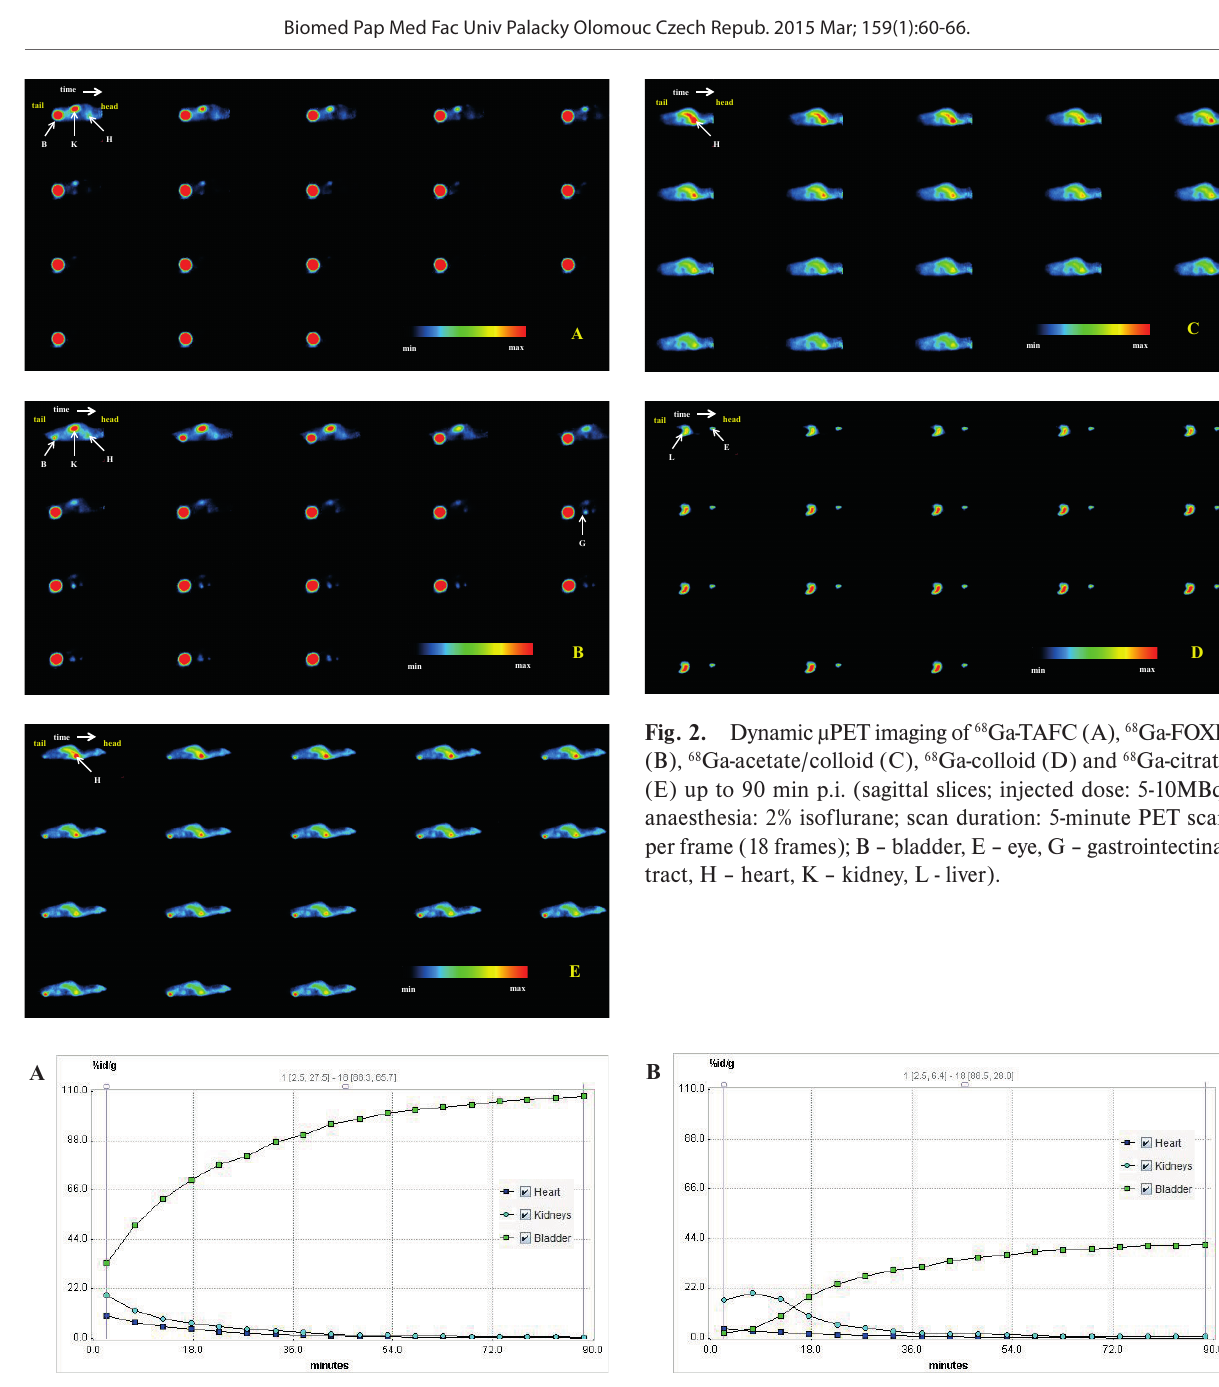
Fig. 3. Time activity curves of selected regions of interest (heart, kidneys, bladder) of 68 Ga-TAFC (A) and 68 Ga-FOXE